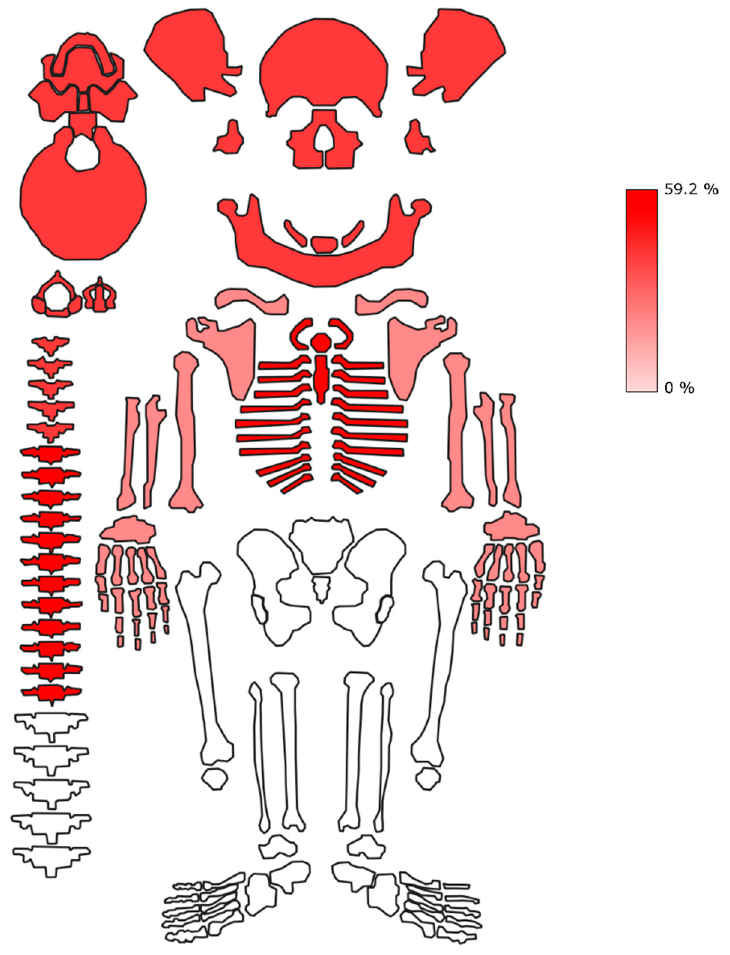
Figure 4. Anatomical location of bone lesions in the complete sample, expressed in frequencies (%) of total number of reported trauma (N = 71). Head and neck and thorax show the highest density of skeletal exposure. Conversely, no bone lesions are present in the abdomen and the lower extremities. Table 7. Tool dimension categories (cat.) in number of soft tissue injuries (STI) and bone lesions (BL) in among the manners of death (MoD).